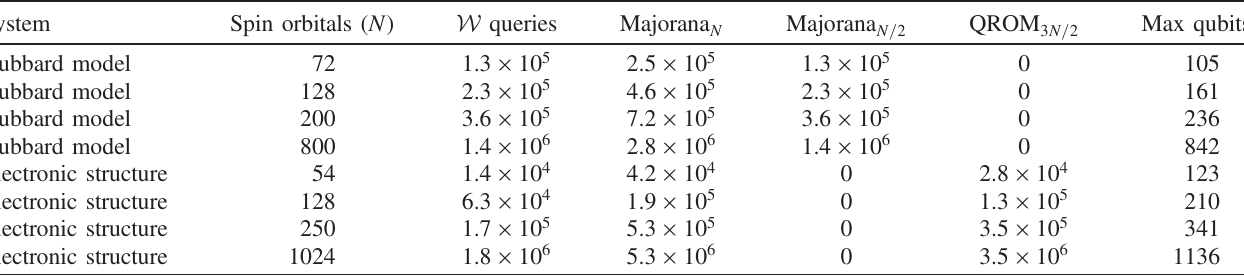
TABLE VI. Cases for which we will calculate the fault-tolerant overhead, along with numbers relevant to estimating the non- negligible components of this overhead. Column 3 contains the number of times that the W oracle is queried. For the Hubbard model, we consider the system at intermediate coupling ( u=t ¼ 4 ), implying that λ ¼ 4 Nt , and we consider an accuracy of Δ E ¼ t= 100 . For jellium, values of λ are provided in Table III, and we target chemical accuracy, which is defined as Δ E ¼ 0 . 0016 Hartree. Each call to W includes a call to SELECT , PREPARE , and PREPARE † , which in turn apply QROM and Majorana operations (which are the dominant costs of the algorithm). Columns 4 and 5 estimate the number of times the Majorana operator circuit (see Fig. 9) must be applied to the entire system or else to half of the system. For electronic structure, there are three Majorana operators of size N per query to W (see Fig. 14). For Hubbard, there are two Majorana operators of size N and one of size N= 2 per query to W (see Fig. 19). Column 6 estimates the number of times QROM lookups (see Fig. 10) of size L ¼ 3 N= 2 are performed. This does not occur in our Hubbard model circuits, but it happens twice per query to W in our electronic structure circuits (once in PREPARE and once in PREPARE † ; see Fig. 15). The final column contains the maximum number of data qubits required at any point in the algorithm, which occurs while applying the Majorana operations in SELECT . This number does not include space to prepare T states, which will be discussed separately.